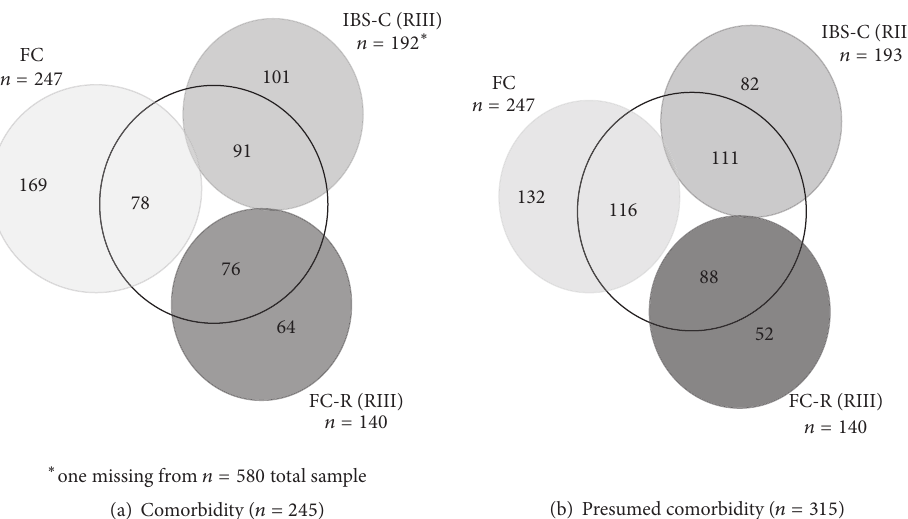
Figure 1: Constipated individuals matching Rome III criteria for IBS (IBS-C: 𝑛 = 193 ) or for functional constipation (FC-R, 𝑛 = 140 ), or not (FC: 𝑛 = 247 ). (a) With acknowledged somatic comorbidity ( 𝑛 = 245 , inner circle); (b) with presumed comorbid condition ( 𝑛 = 315 , inner circle). Note that nearly half of individuals matching diagnostic criteria demonstrated either somatic comorbidity or presumed somatic